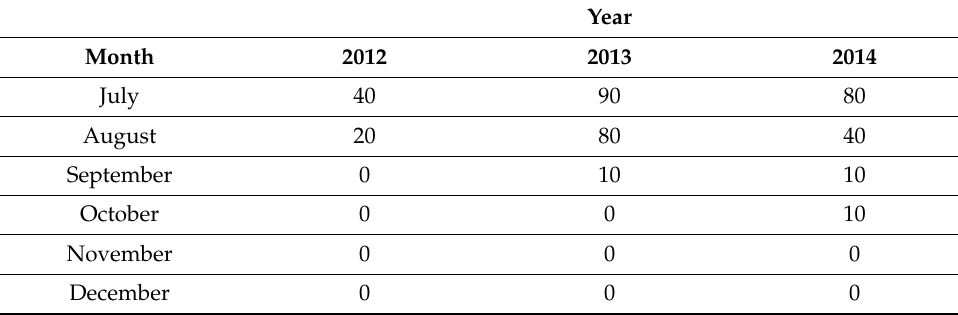
Table 3. Percentage of samples with no mites in the group of colonies not treated with acaricides (V+) for the different years and